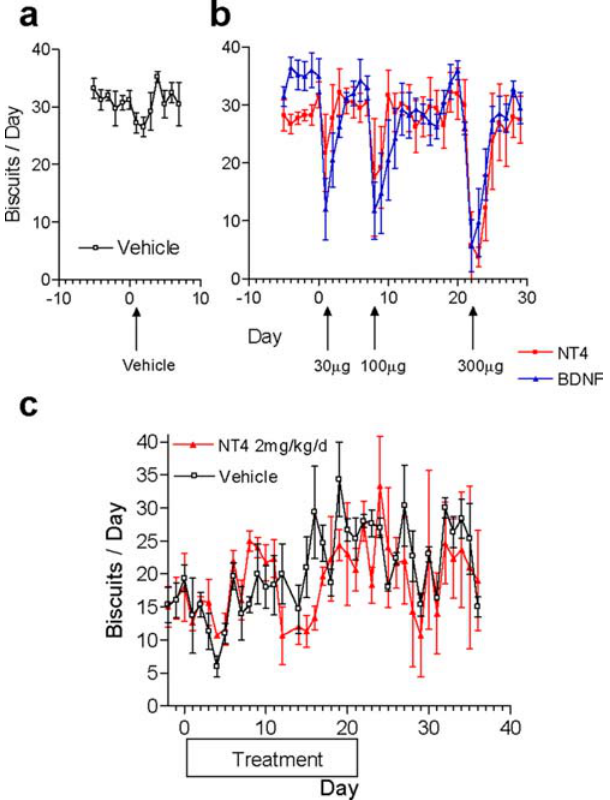
Figure 2. Centrally, but not peripherally, delivered TrkB agonists suppress food intake in Rhesus monkeys. a, Vehicle infusion into normal adult Rhesus monkeys (baseline body weight 4– 7 kg) via an ICV catheter did not substantially change the food consumption (n=2 males and 2 females per group). b , Dose dependent and reversible decrease in food intake followed ICV infusion into normal adult Rhesus monkeys of increasing doses of NT4 or BDNF (n=2 males and 2 females per group). c , Daily SC injections of 2 mg/kg NT4 (n=1 male and 2 females per group) over 21 days in lean, adult Rhesus monkeys (baseline body weight 3–6 kg) did not significantly alter the level of daily food intake.